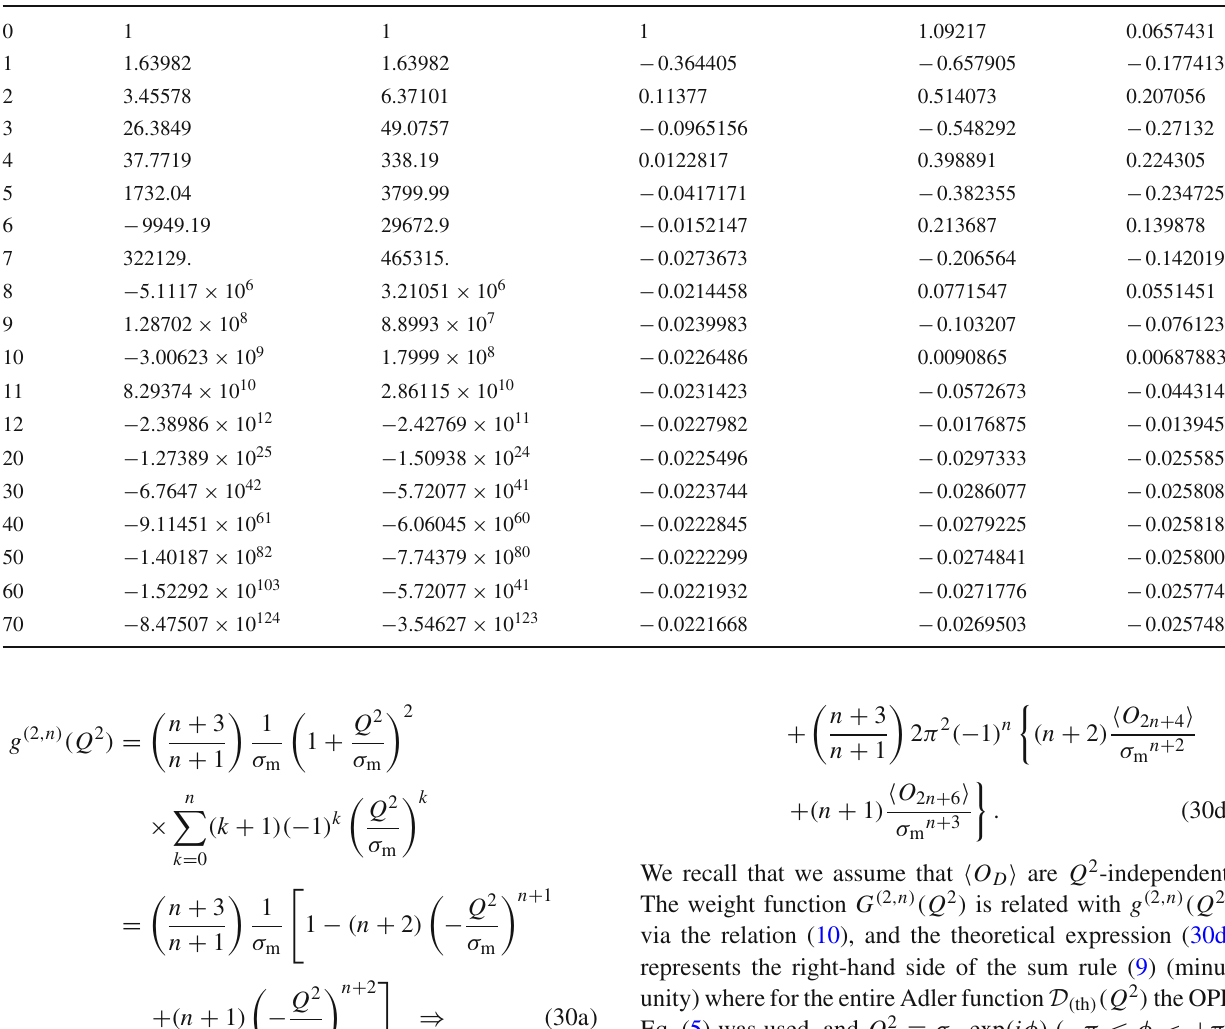
quantity (cid:8) d ( Q 2 ; κ) Eq.(18),andthecoefficients d n arethengeneratedby therelations(17).Thevaluesofthefirstfourcoefficients( n = 0 , 1 , 2 , 3) coincide with the exactly known values. See the text for